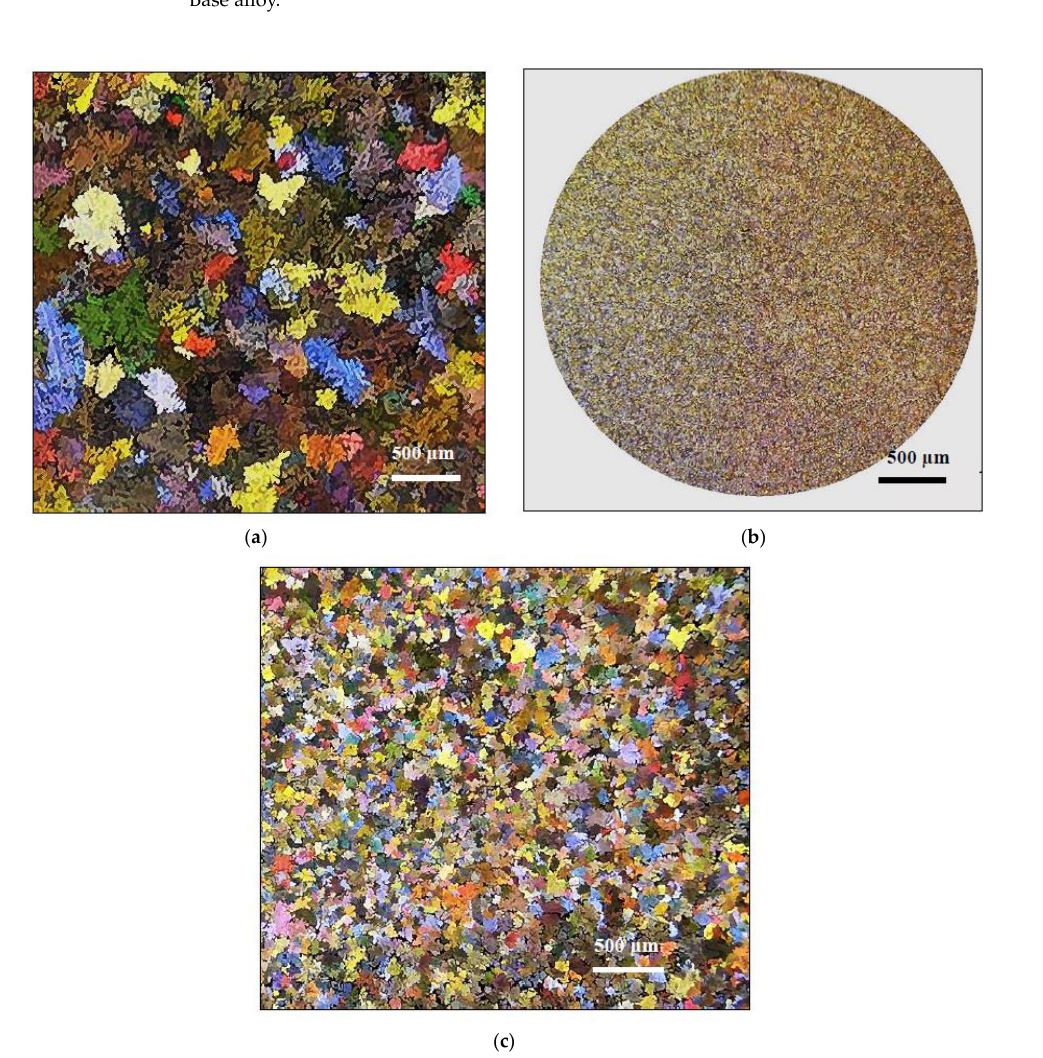
Figure 5. Solidification curves and their first derivatives from samples solidified at the rate of ~0.35 C/s: ( a ) experimental alloy, ( b ) alloy A, ( c ) alloy B, and ( d ) alloy C.